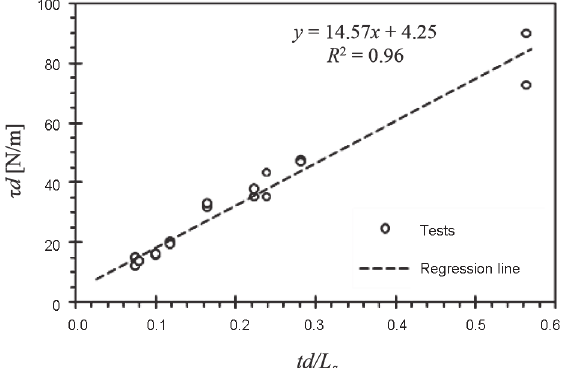
Fig. 7. τd versus td/L s for the tests of slab specimens using 76 mm deck with 0.9, 1.2 and 1.5 mm sheeting thicknesses (Specimens #1 – #9 of Table 1)